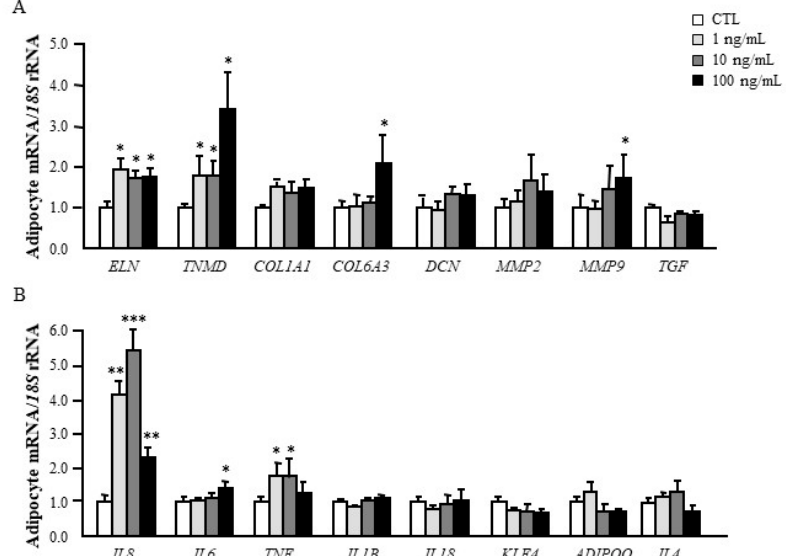
Figure 3. DPT induces the expression of ECM- and inflammation-related factors in human visceral adipocytes. Gene expression levels of extracellular matrix remodelling-related molecules ( A ) as well as inflammatory factors ( B ) in human visceral adipocytes stimulated with recombinant DPT (1, 10 and 100 ng / mL) for 24 h. Gene expression levels in unstimulated cells were assumed to be 1. Values are the mean ± SEM ( n = 6 per group). Di ff erences between groups were analysed by one-way ANOVA followed by Dunnet’s post hoc tests. * p < 0.05, ** p < 0.01 and *** p < 0.001 vs. unstimulated